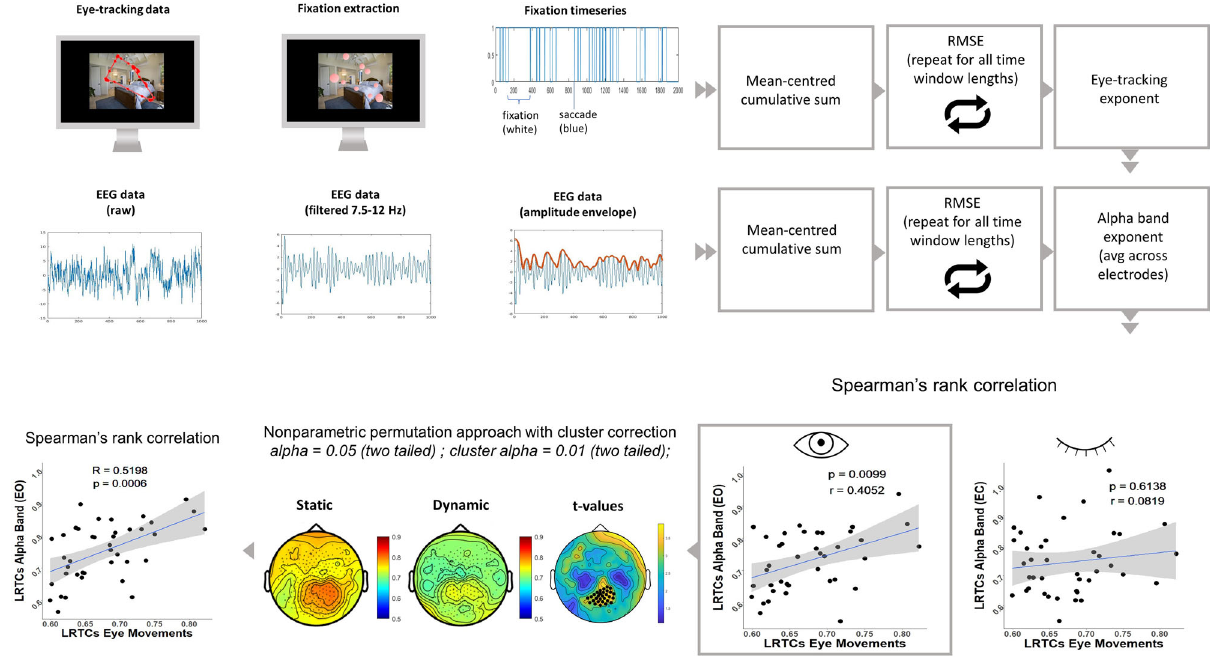
Fig. 3 Procedure and results for DFA analysis. Work fl ow for DFA analysis. For eye-tracking data, after extracting fi xations with a velocity-based algorithm, a fi xation timeseries is built (where 0 = fi xation; 1 = saccade). EEG data are the fi rst bandpass fi ltered in the frequency of interest (7.5 – 12 Hz, fi lter order = 66), then the amplitude envelope is computed. For both timeseries, DFA analysis is performed. First, a correlation between eye-tracking exponents and mean alpha band exponents (i.e., averaged across 256 channels) is computed. A signi fi cant positive correlation is found in the eyes open condition ( r = 0.405, p = 0.009). In this condition, Spearman ’ s rank correlation coef fi cients are computed in each electrode between alpha band DFA exponents and eye-tracking DFA exponents. Null hypothesis testing is conducted by using the nonparametric permutation approach with cluster correction. Black dots index signi fi cance with cluster alpha at p < 0.01 (two-tailed) and alpha p < 0.05 (two-tailed). Finally, a Spearman ’ s rank correlation is computed between DFA exponents in eye movements and DFA exponents in alpha band in the signi fi cant cluster of electrodes ( r = 0.455, p = 0.003). All the scatterplots show Spearman ’ s r , p -value, and 95% CI. N = 40. LRTCs long-range temporal correlations, RMSE root-mean-square